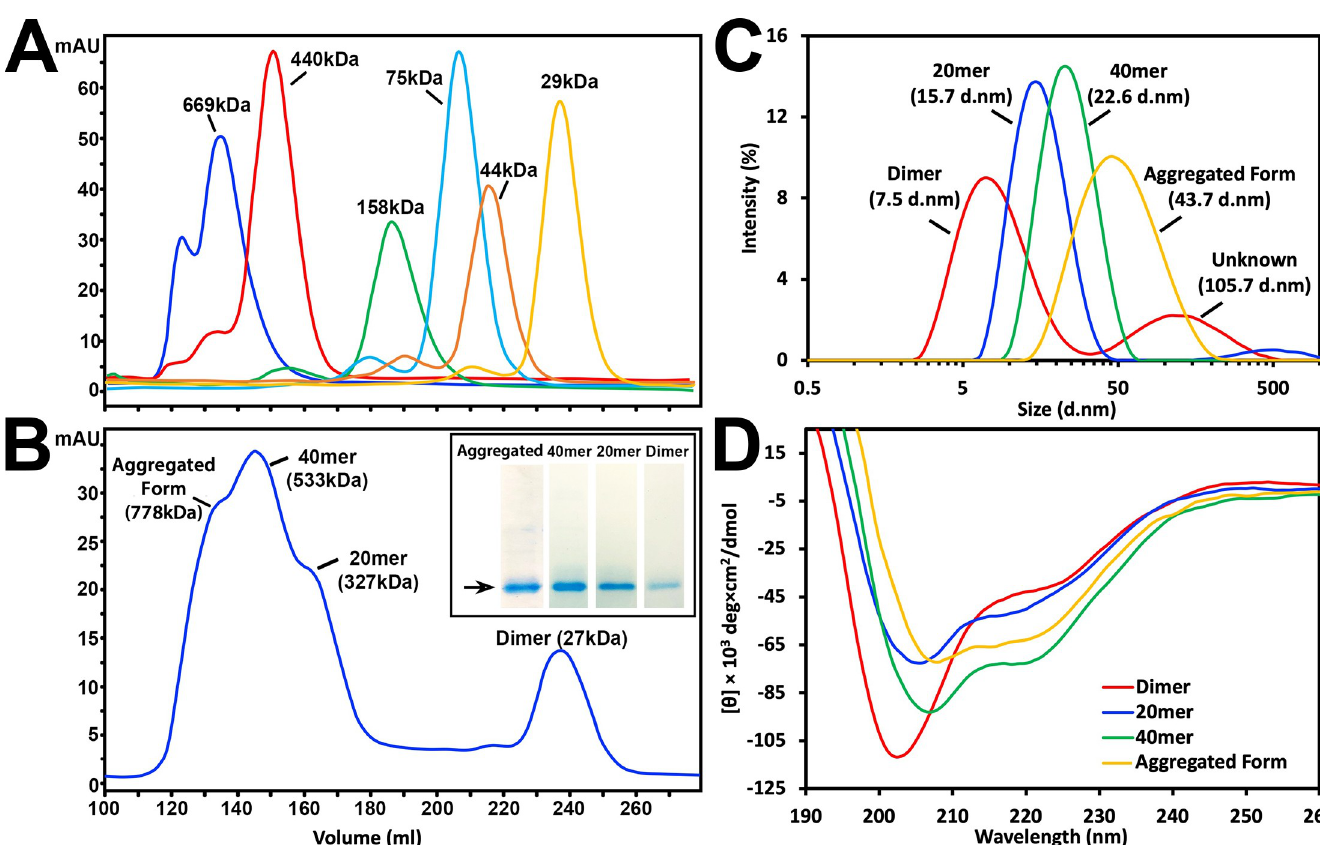
Fig 2. Purification of hPER2c by SEC and DLS/CD profile of all four forms of hPER2c. (A) Chromatogram of molecular standards: thyroglobulin 669kDa (blue), ferritin 440kDa (red), aldolase 158kDa (green), conalbumin 75kDa (cyan), ovalbumin 44kDa (orange), and carbonic anhydrase 29kDa (yellow). (B) Chromatogram of hPER2c purification showing four different peaks at 778kDa, 533kDa, 327kDa, and 27kDa. Based on calibration in (A), these four peaks were named as aggregated form, 40mer, 20mer, and dimer as described in main text and used in the following panels. Coomassie blue stained 10% SDS-PAGE gel of purified recombinant hPER2c for each form were show on the side. Most of them except the aggregated form showing a single band. (C) DLS spectra of peak fraction from SEC in (B). The peaks for aggregated form, 40mer, 20mer, and dimer are labeled with their corresponding measured hydrodynamic radius. (D) CD spectra of peak fraction from SEC in (B). In both panel (C) and (D), the DLS and CD Spectra of aggregated, 40mer, 20mer, and dimer forms of recombinant hPER2c were colored in yellow, green, blue, and red, respectively. https://doi.org/10.1371/journal.pone.0221180.g002 suggested by the instrument manufactory white paper (Malvern Instruments Worldwide). Y- intercept values at all forms were higher than 0.6 again indicating good quality of the DLS data.